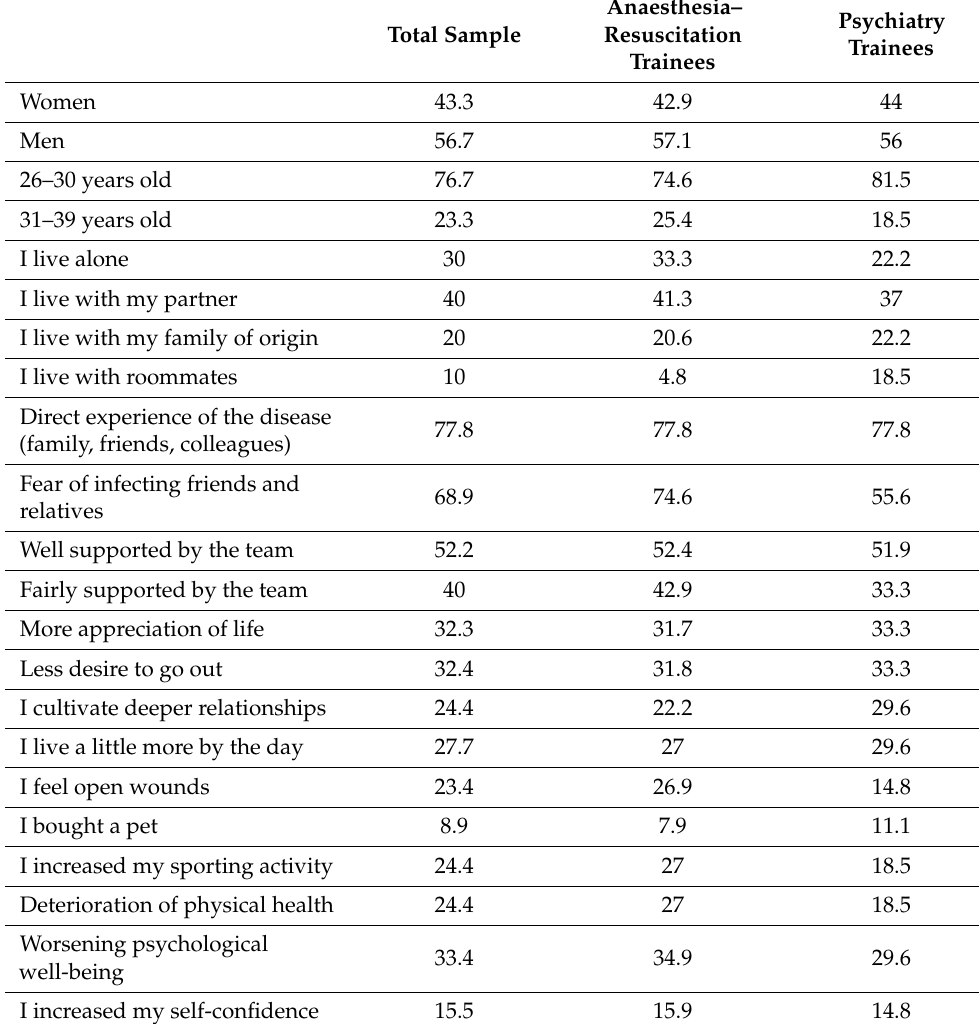
Table 1. Percentages for the whole sample and in the separate samples of anaesthesia–resuscitation and psychiatry residents of the items of the ad hoc questionnaire.